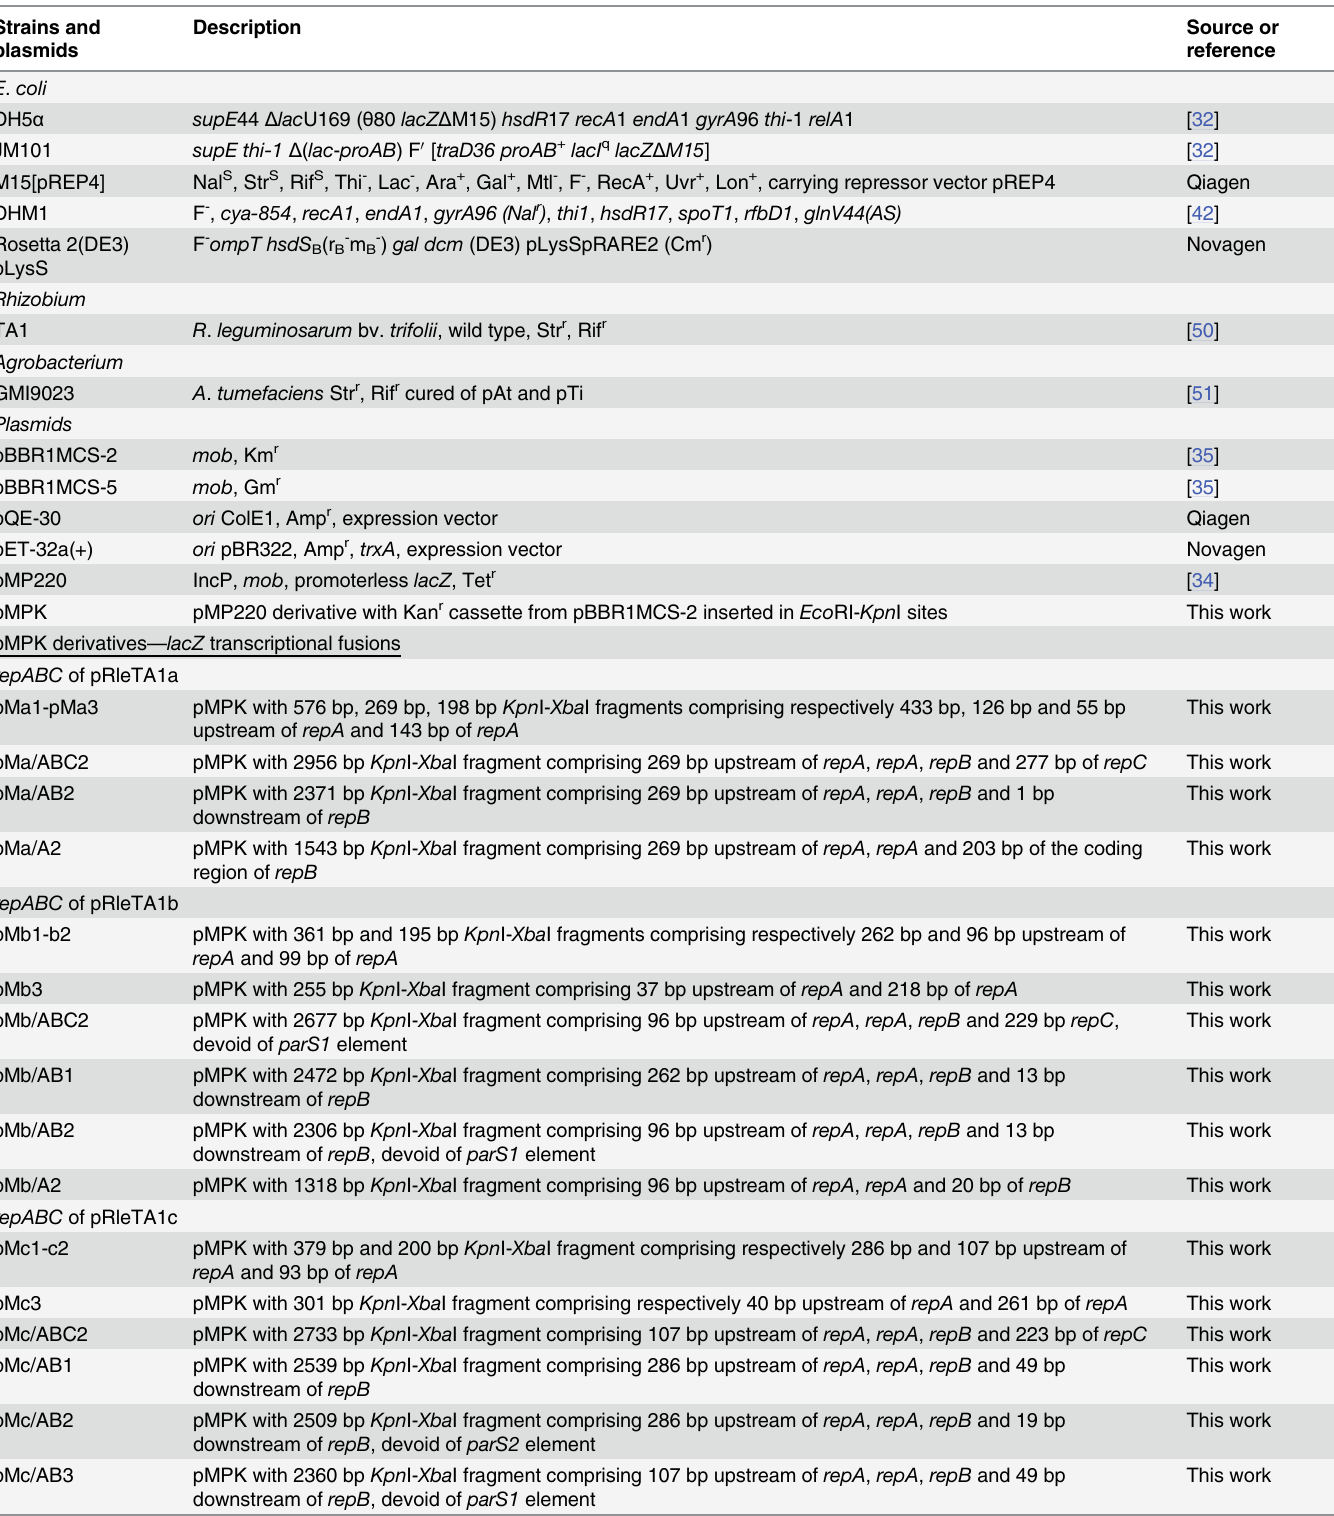
Table 1. Strains and plasmids used in this study. Strains and